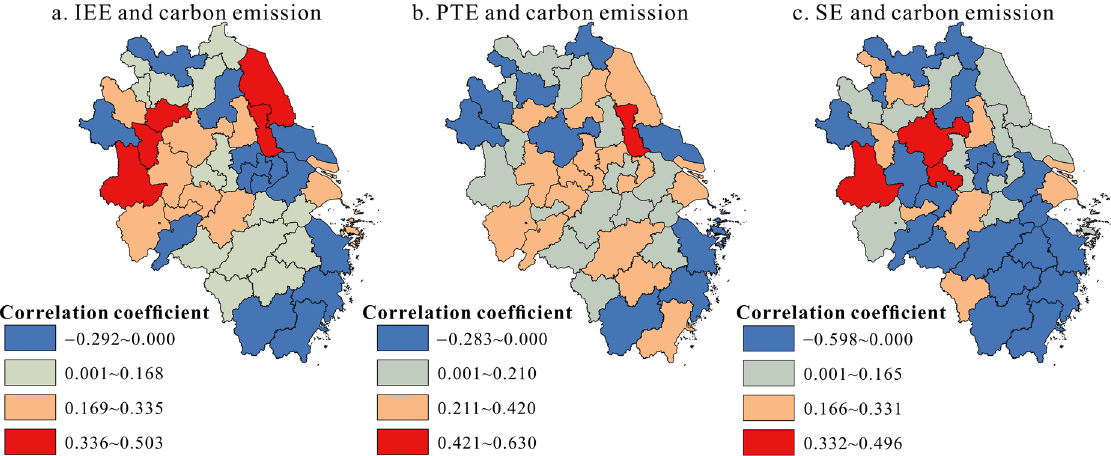
Figure 2. Spatial correlation intensity between ( a ) IEE and carbon emissions, ( b ) PTE and carbon emissions, ( c ) SE and carbon emissions.